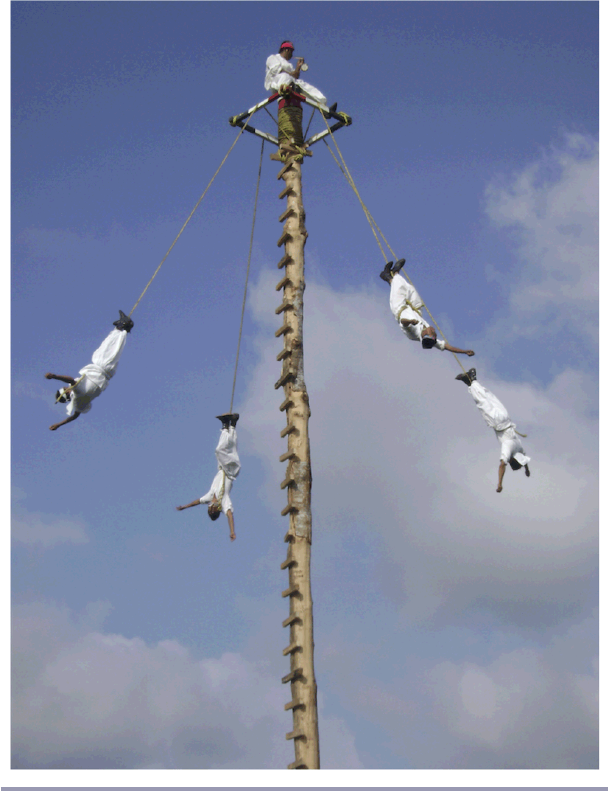
Fig. 1 . Ritual ceremony of the Voladores in Papantla,